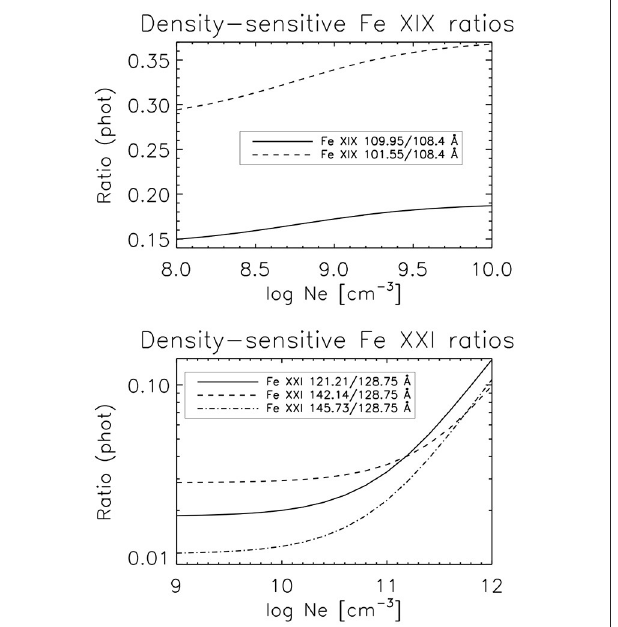
FIGURE 3 | A few of the available SXR density-sensitive